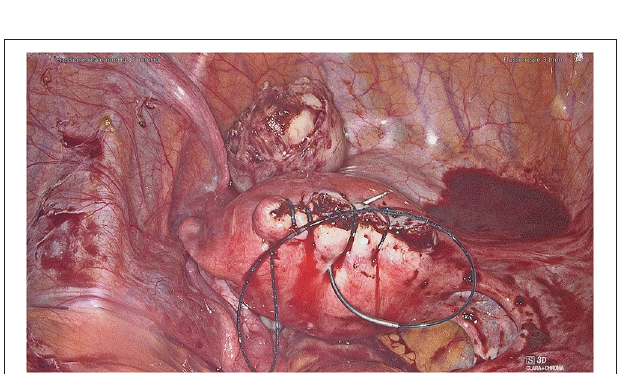
FIGURE 3 | Tighten the suture by one or more backwards